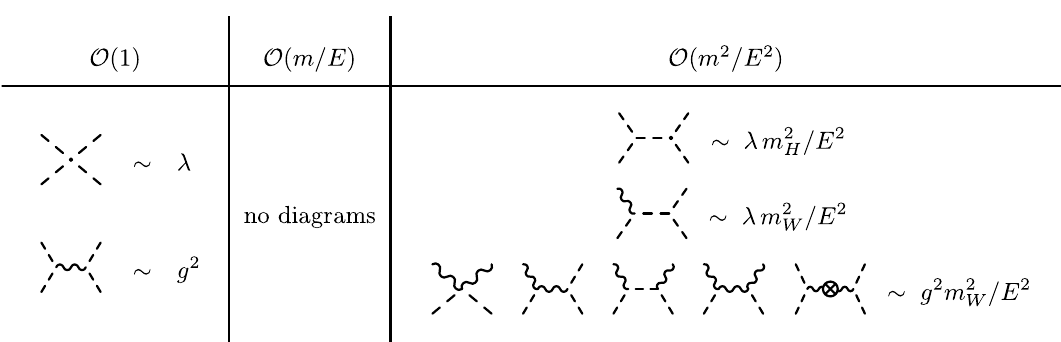
( W → W ) and their scal- W W 0 0 0 0 M